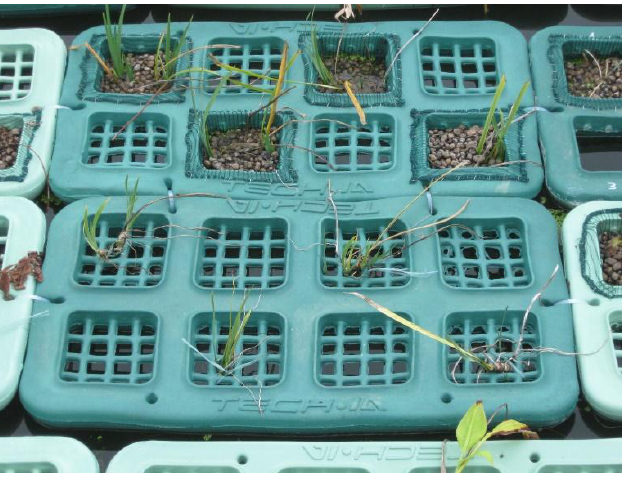
Figure 4. Particular of two TECH-IA ® elements in which the plants were set with ( above ) or without ( below ) the substrate of expanded clay.